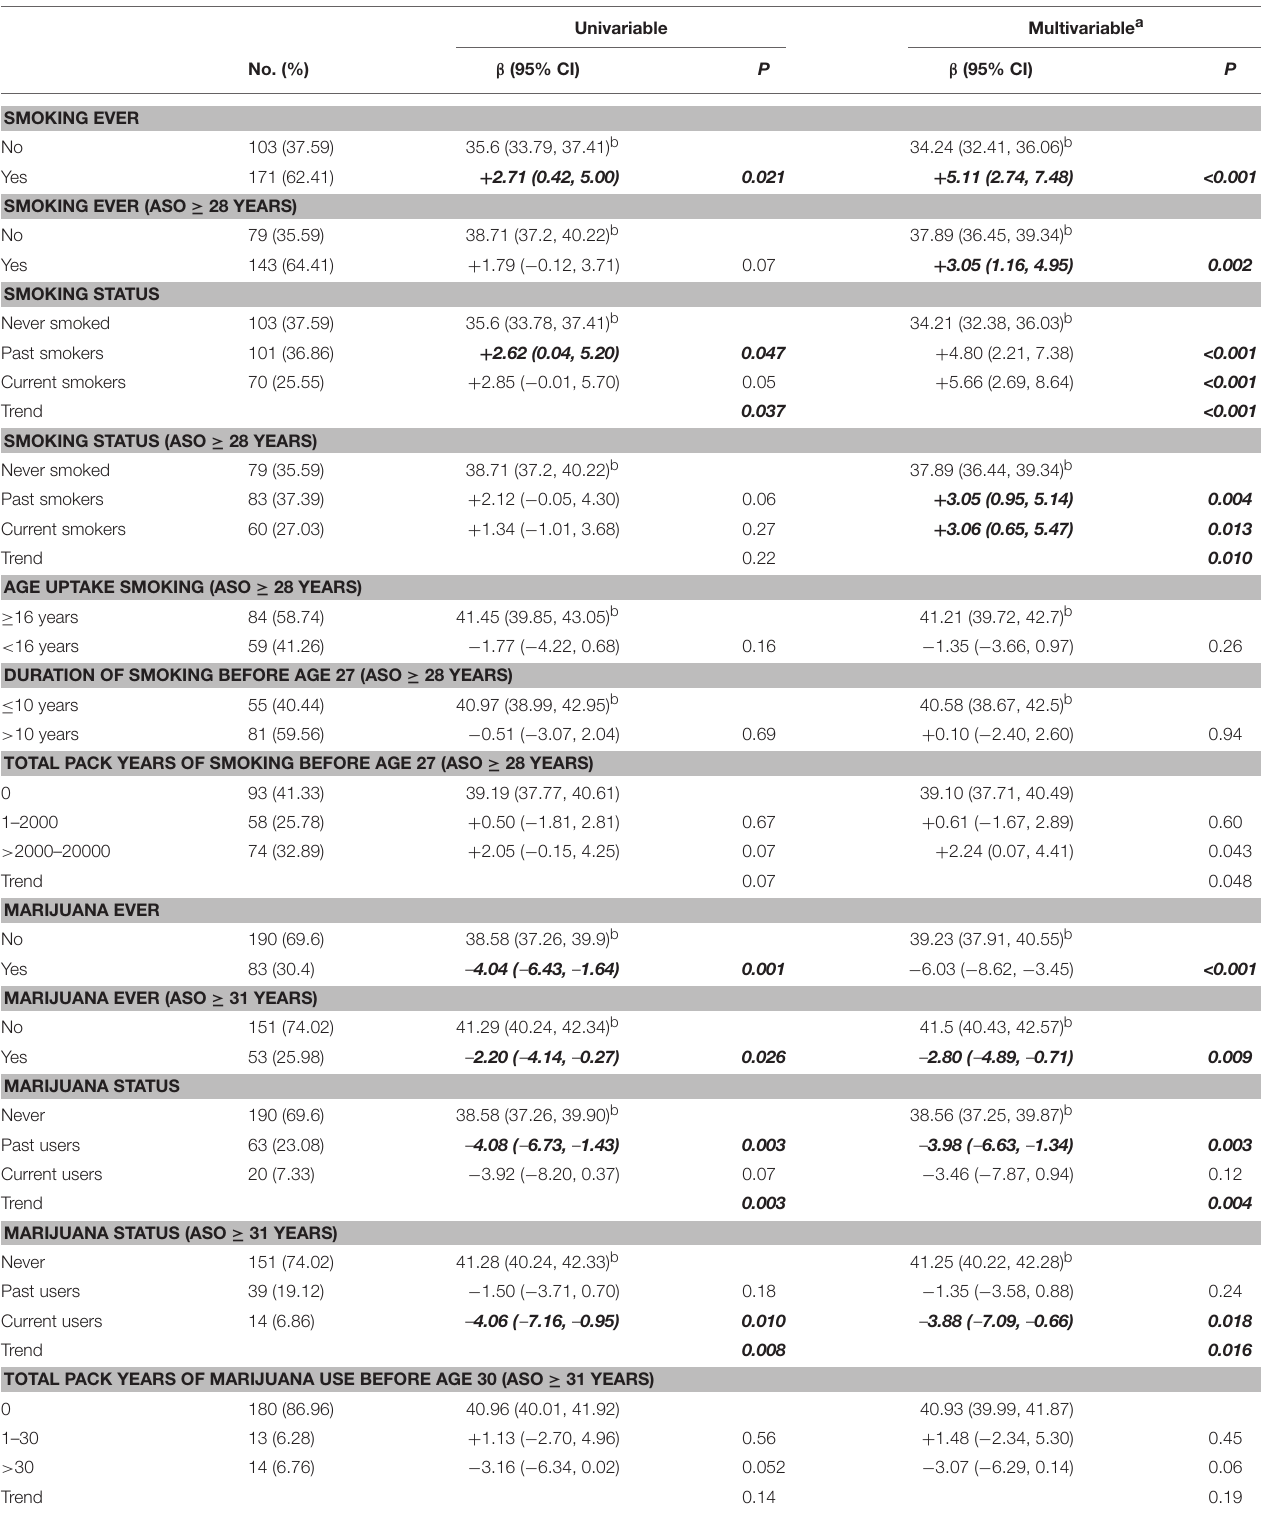
TABLE 3 | Associations between smoking behaviors and age of symptom onset. Univariable Multivariable